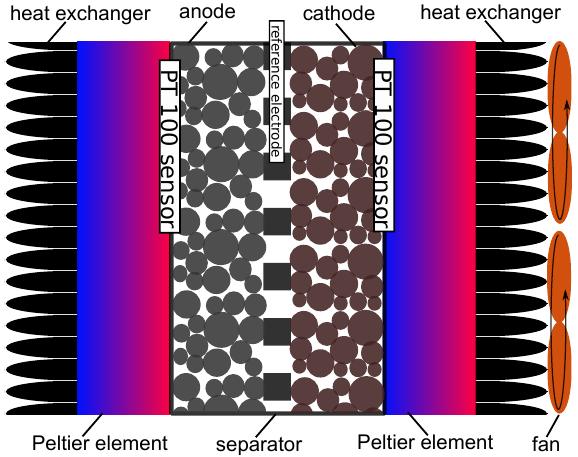
Figure 2. Schematic illustration of the measurement setup. Two 60-mAh high-energy density Lib cells produced by Custom Cells, denoted as cell I and cell II, with roughly 17 cm² NMC and graphite electrodes respectively have been analysed with a Gamry Reference 3000 potentiostat. Both cells had a Lithium titanate (LTO) reference electrode integrated for the half-cell measurements. Measurements for the full cell were conducted as well on the cells with reference electrode. All measurements have been performed at 50% SoC referred to the nominal capacity. Impedance spectra have been measured from 0.1 Hz–10 5 Hz with an amplitude of 6 mA. The cells have been stored at room temperature and 50% SoC between the